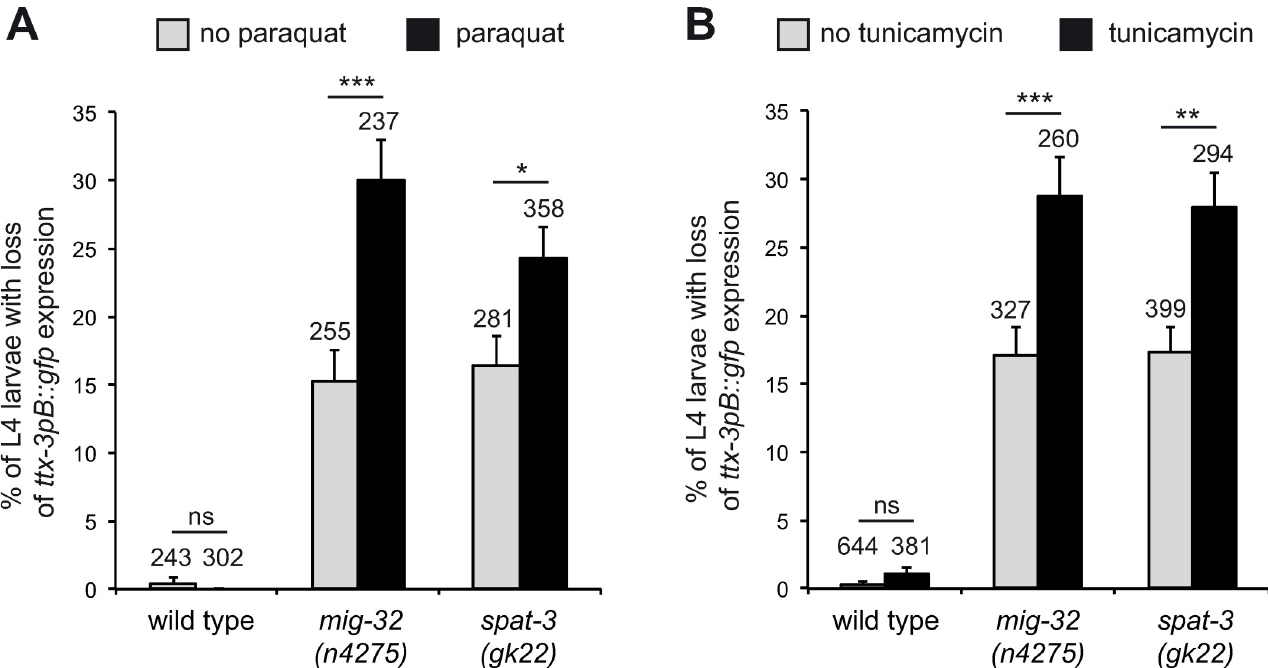
Fig 7. Effect of stress on AIY neurons. Percentage of L4 larvae that display a loss of ttx-3pB :: gfp ( otIs173 ) expression in one or two AIY neurons in wild type or PRC1 mutant animals, in absence or presence of paraquat (A) or tunicamycin (B). Error bars show standard error of proportion, numbers above the bars show number of animals analyzed ( ��� p < 0.001, �� p < 0.01, � p < 0.05, ns not significant, Fisher’s exact